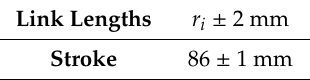
Table 6. Link length variation cases for Step S3.